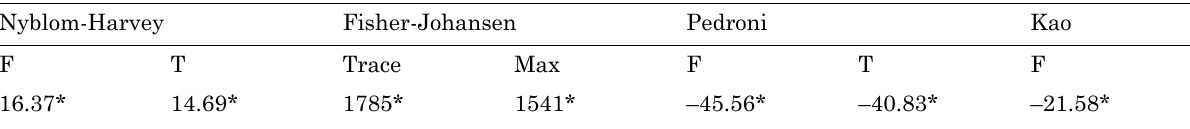
Table 3. Panel cointegration